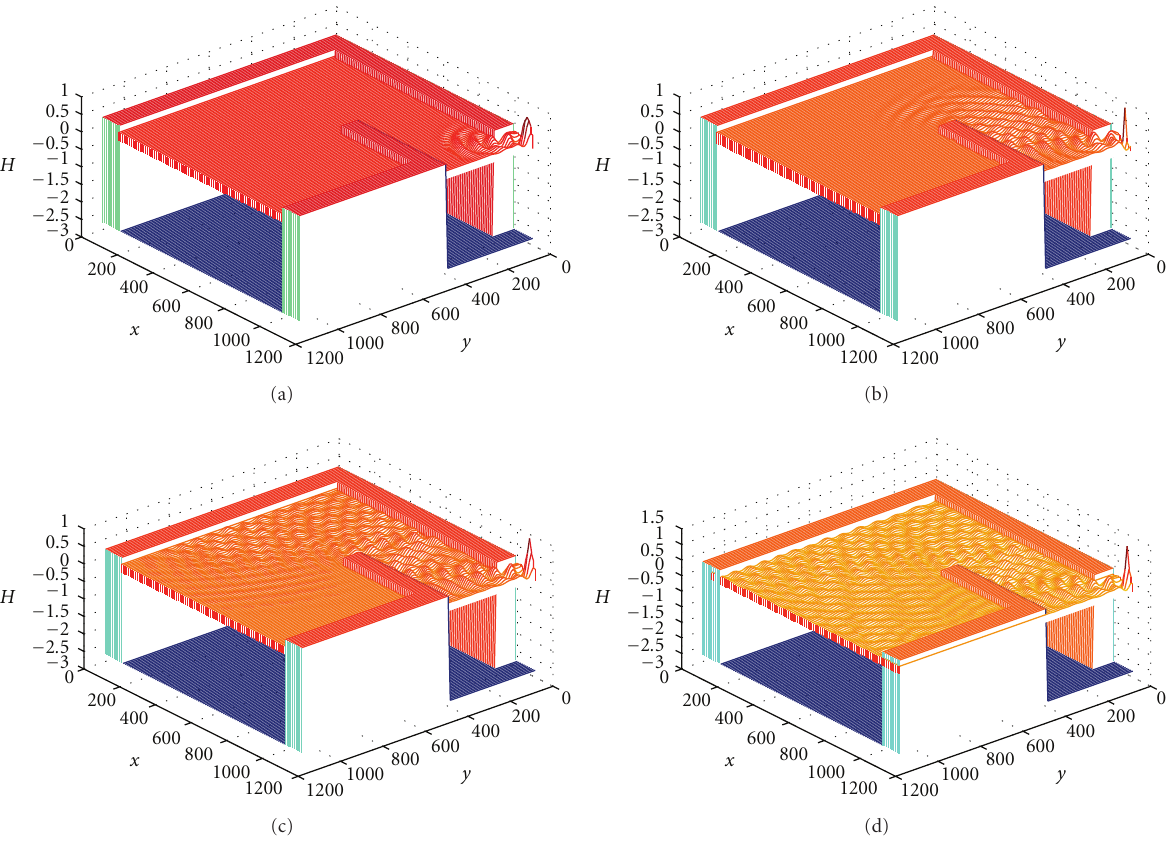
Figure 15: Snapshots of the wave height distribution into the breakwater idealized at 16 seconds (a), 34 seconds (b), 50 seconds (c) and 64seconds (d).